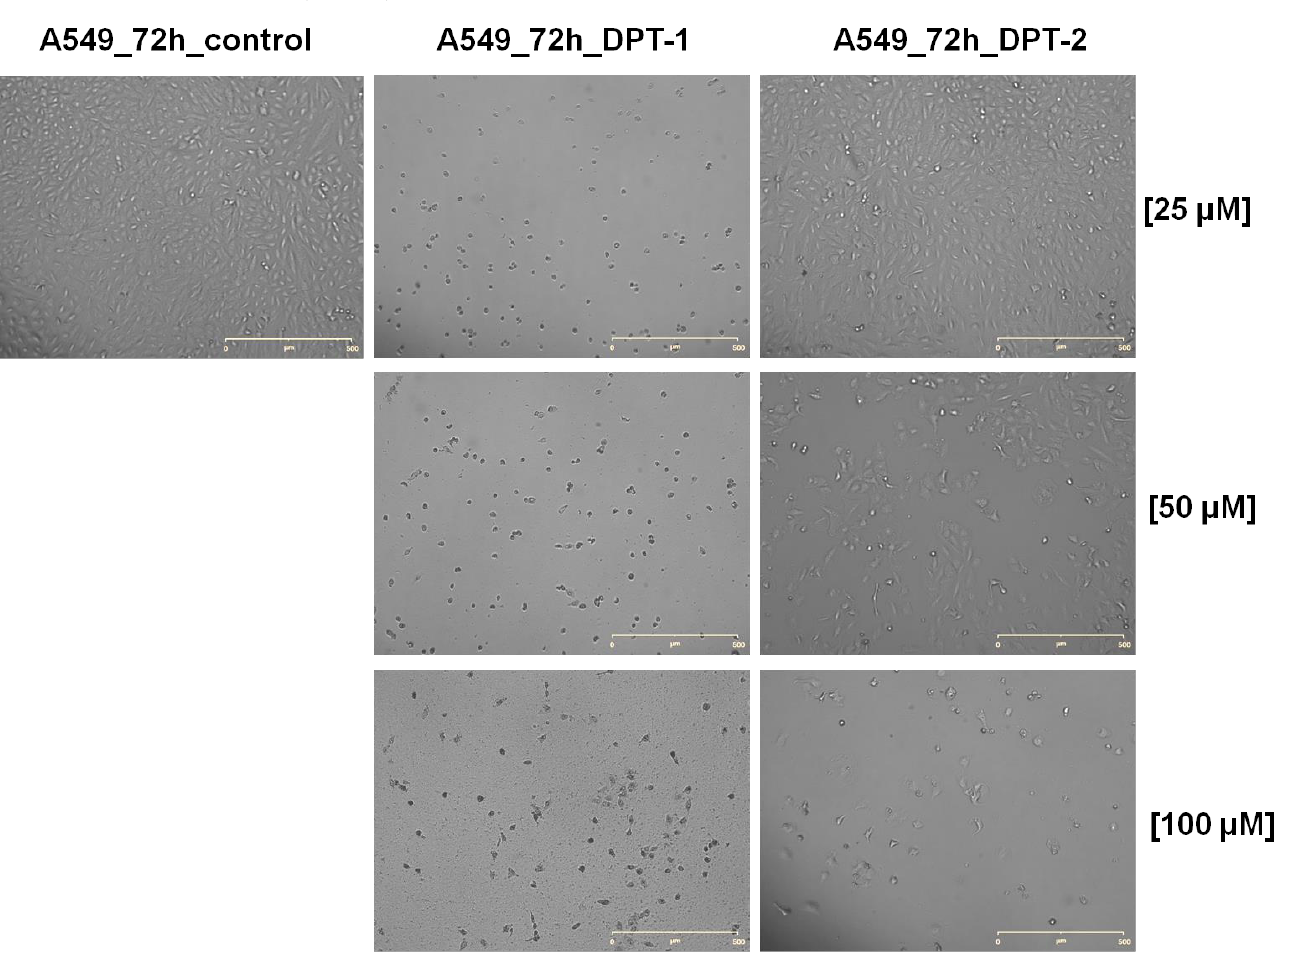
Figure 10. Dose-dependent cellular death in control and DPT-1 - and DPT-2 -treated A549 cells treated for 72 h, followed by Live Cell Analyzer images acquisitions. Magnification 100×; scale bar 500 µM. Table 2. The molecular descriptor and parameters of Lipinski’s, Ghose’s and Veber’s rules for DPT-1 and DPT-2 [32]